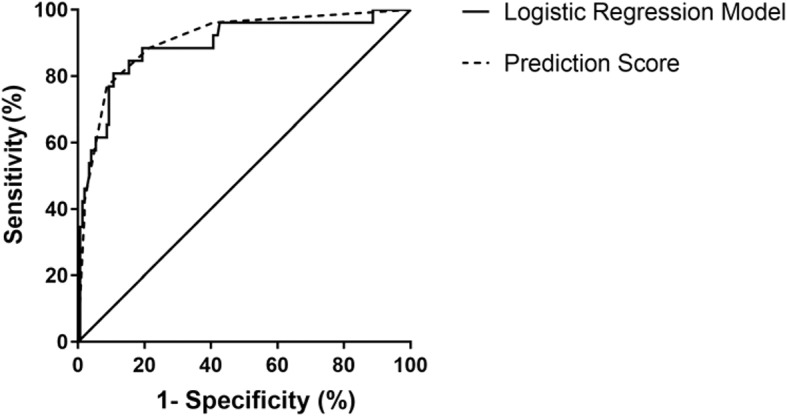
ROC curve of the diagnostic value of the logistic regression model and the scoring model between VVS and PPS. The y-axis represents sensitivity. The x-axis represents false positive rate (1-specificity). The 45° straight line stands for the reference line indicating sensitivity being equal to false positive rate. In the logistic regression model, the AUC was 0.892 (95% CI: 0.815–0.969; P < 0.001) and in the scoring model, the AUC of was 0.909 (95% CI: 0.845–0.973; P < 0.001). AUC, area under the curve; CI, confidence interval; PPS, psychogenic pseudosyncope; ROC, operation characteristic curve; VVS, vasovagal syncope.